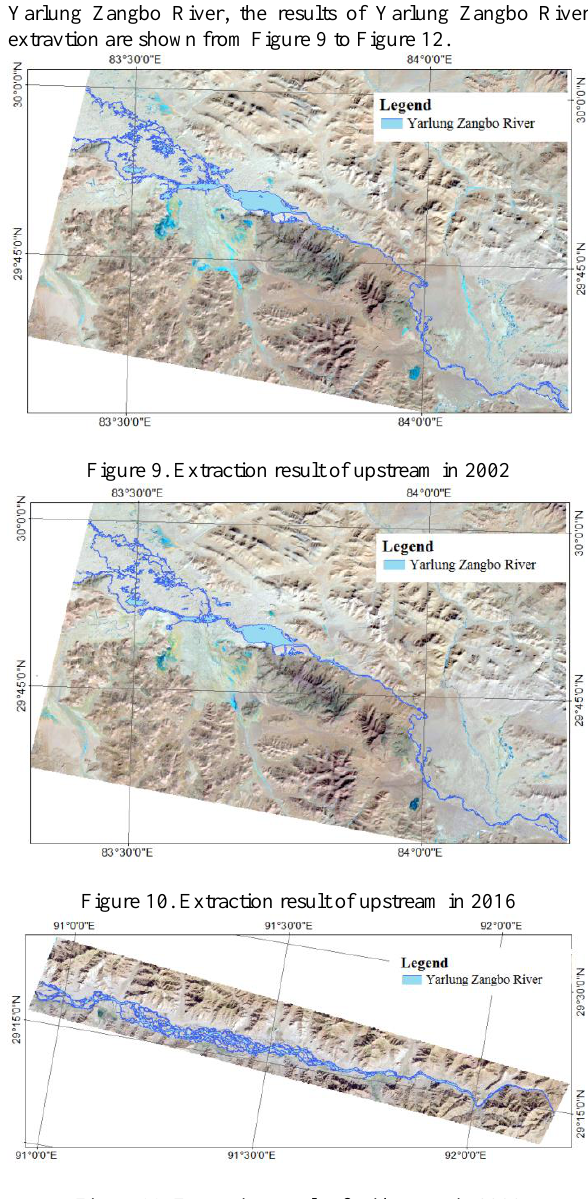
Figure 11. Extraction result of midstream in 2000